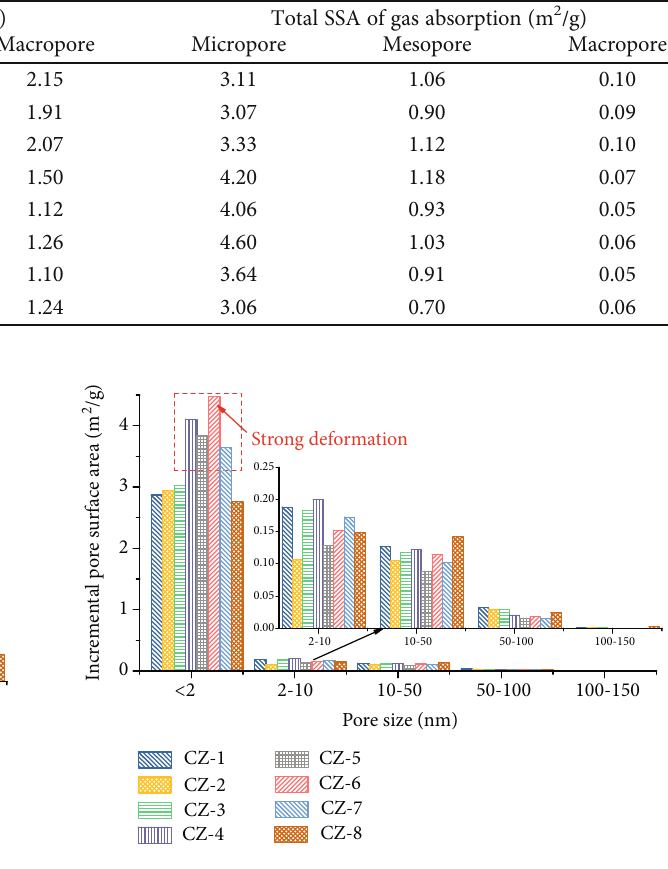
Figure 4: Pore volume distribution of the Lujiaping shale from the data of LPGA experiments.